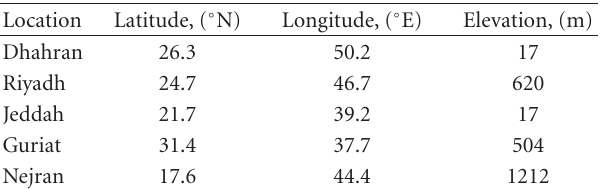
Table 1: Geographical coordinates of meteorological stations considered in this study.